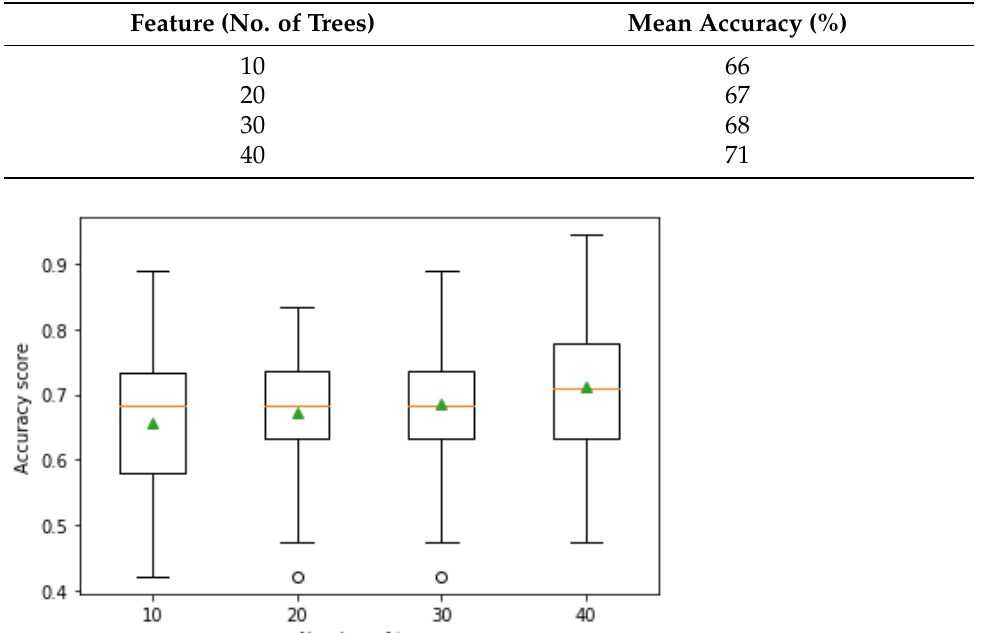
Table 12. Nepal: Predictive accuracy score against number of trees for each ensemble.